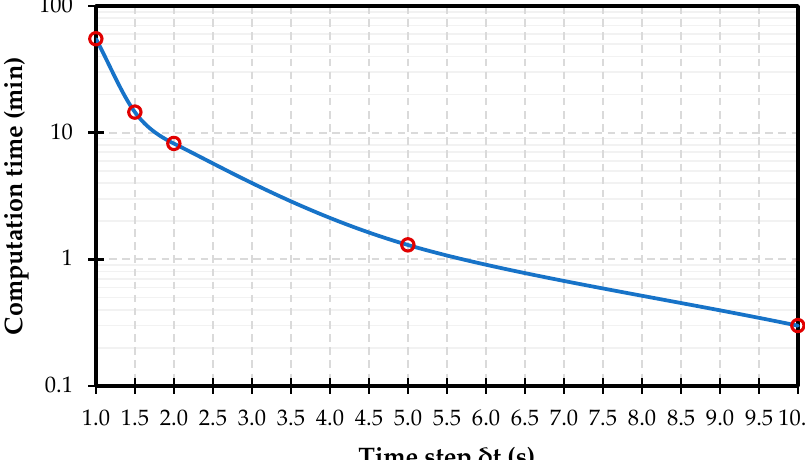
Figure 8. Evolution of computation time for different values of δ t used.